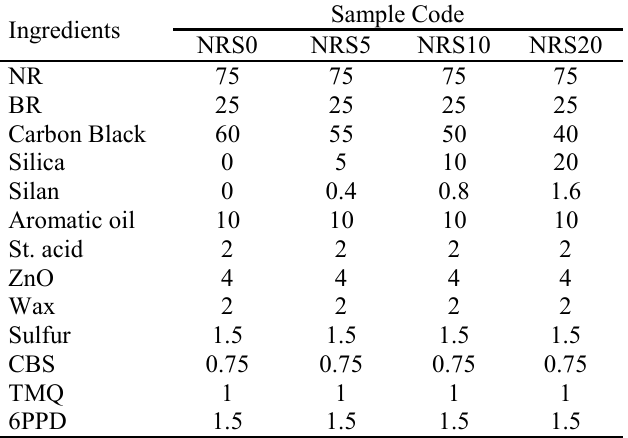
Table 1. Compound Formulations (Unit: